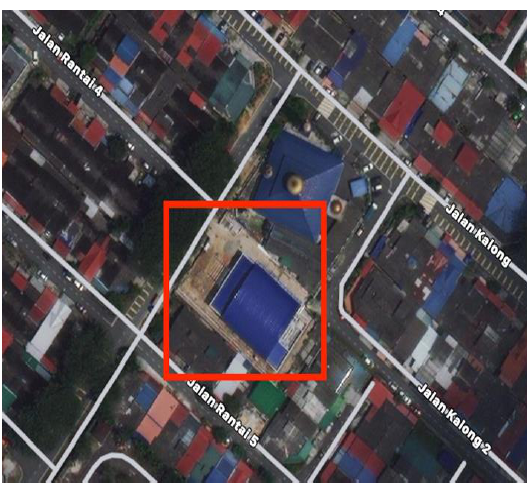
Figure 1: Location of Dewan Muafakat (Source: Google Map)